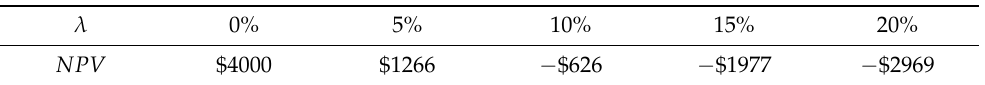
Figure 1. Cash flow example 1 related to selection of two battery technologies. Table 1. Incidence of the discount rate on the net present value (NPV) for the selection of two battery technologies.